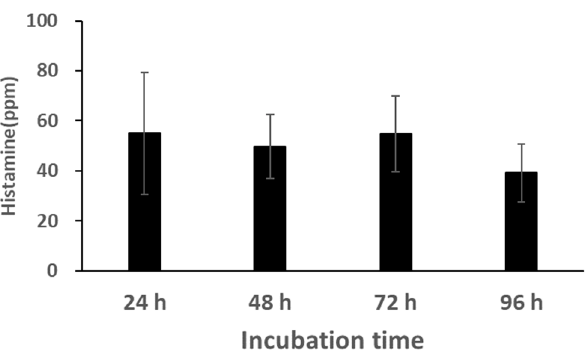
Figure 7. Histamine concentrations in mixtures of internal organs of white sturgeon reacted at 50 °C for 96 h. Values are mean ( n = 3).